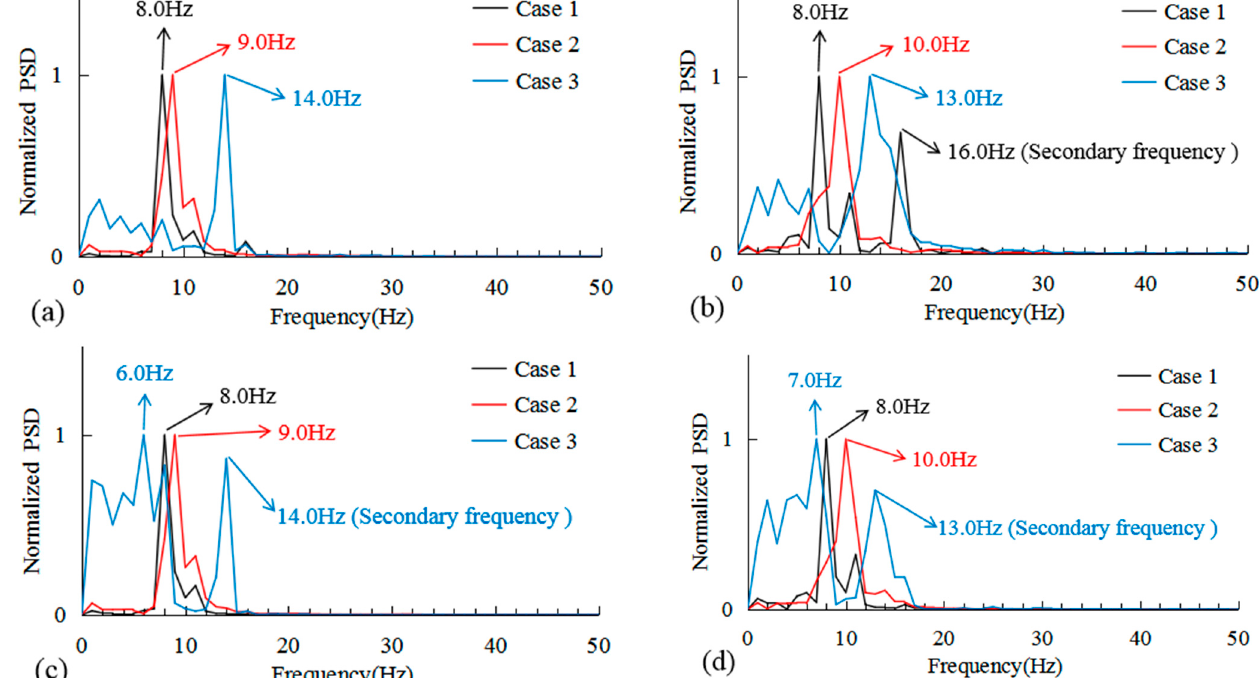
Figure 13. PSD in the vibration response initial stage: ( a ) d1, ( b ) d1, ( c ) d3, ( d ) d4.